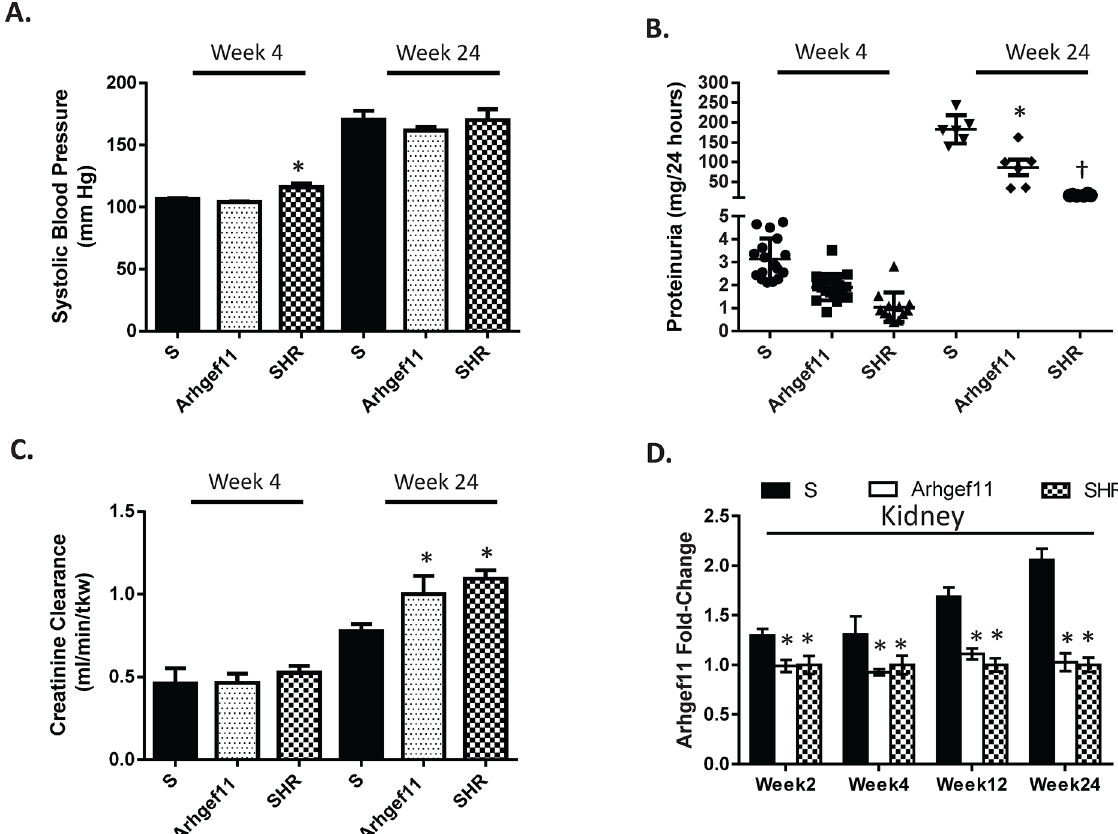
Fig 1. Blood pressure, proteinuria, and renal function measurements and correlation with changes in Arhgef11 expression. ( A ) Systolic blood pressure in S, Arhgef11-congenic (C), and SHR at week 4 and 24 (n = 6 per group). ( B ) Proteinuria as a measure of renal injury (n = 6 – 20). ( C ) Creatinine clearance as an indication of renal function (n = 4 – 6 per group). ( D ) Renal expression of Arhgef11 from week 2 (before phenotypic differences between strains) until week 24 (n = 6 per group/time). Arhgef11-congenic is genetically similar to the S rat, except for allelic difference in Arhgef11 (S2 Fig) and few surrounding genes. * p < 0.05 versus S, † , p < 0.05 versus S and C. SE are presented.